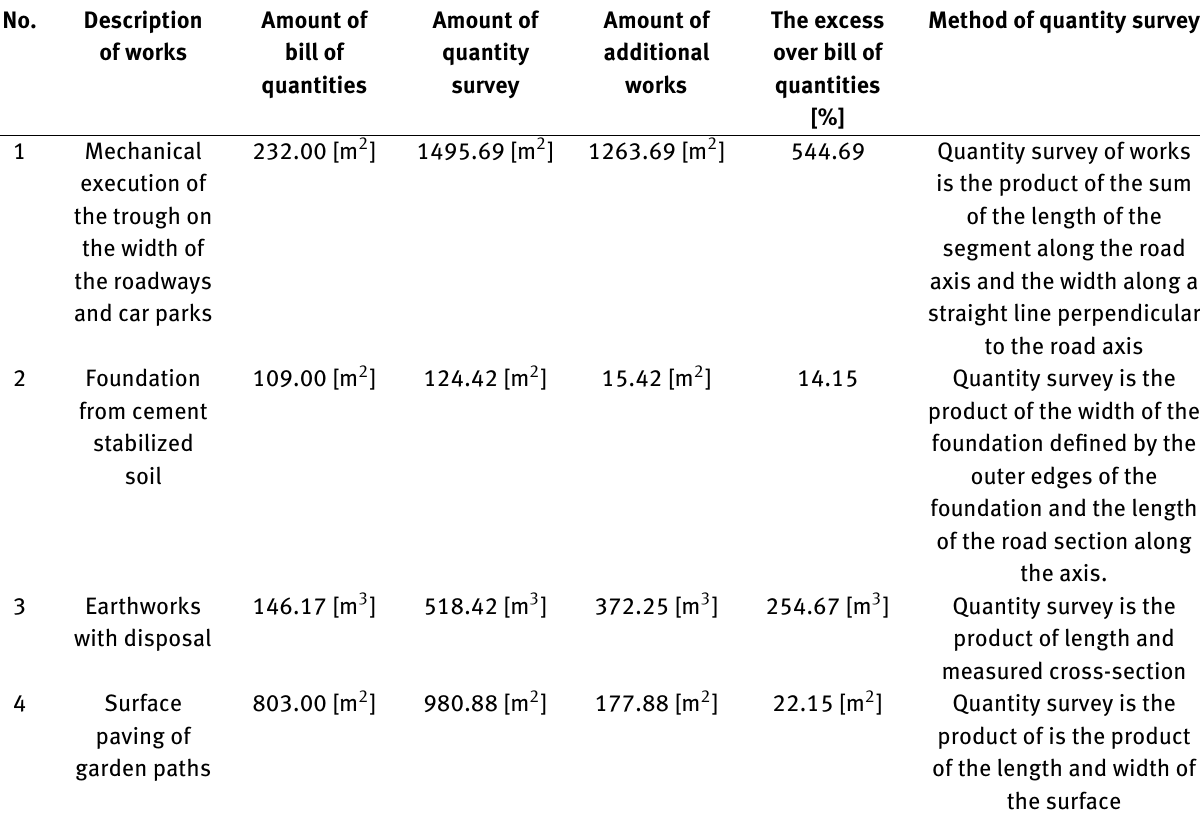
Table 3: List of bill of quantities and quantity survey of selected renovation works for comparison facility No. 1 - renovation of external communication routes of the historic